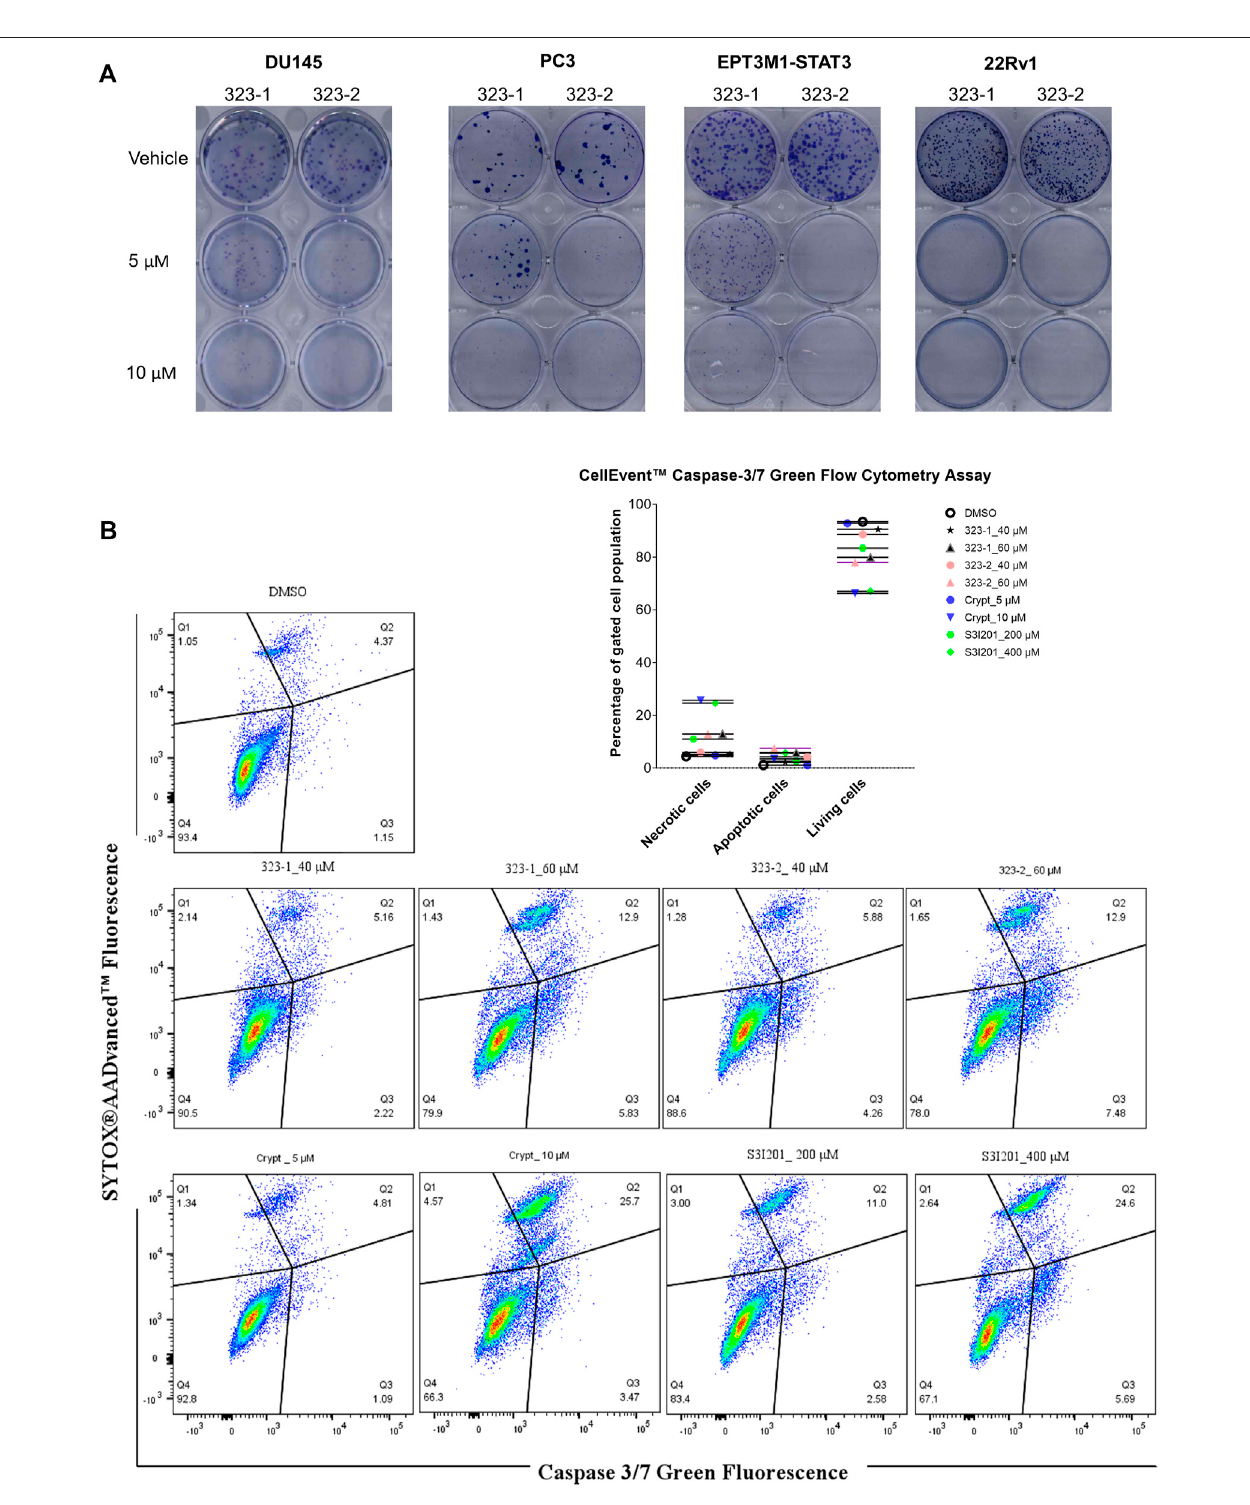
FIGURE5| Compound 323sreducedtheclonogenicityand inducedapoptosis. (A) Onthe2nddayafterseeding,compounds323 – 1and 323 – 2wereaddedand DU145, PC3, EPT3M1-STAT3, and 22Rv1 cells were allowed to grow for 2 weeks to form colonies and next stained with 0.4% crystal violet (w/v). (B) Flow cytometric analyses of cell apoptosis induced by treatment with vehicle (DMSO), 323 – 1, 323 – 2, cryptotanshinone, or S3I201 at indicated concentrations for 72 h in DU145 cells. Data are representative results of three experiments.